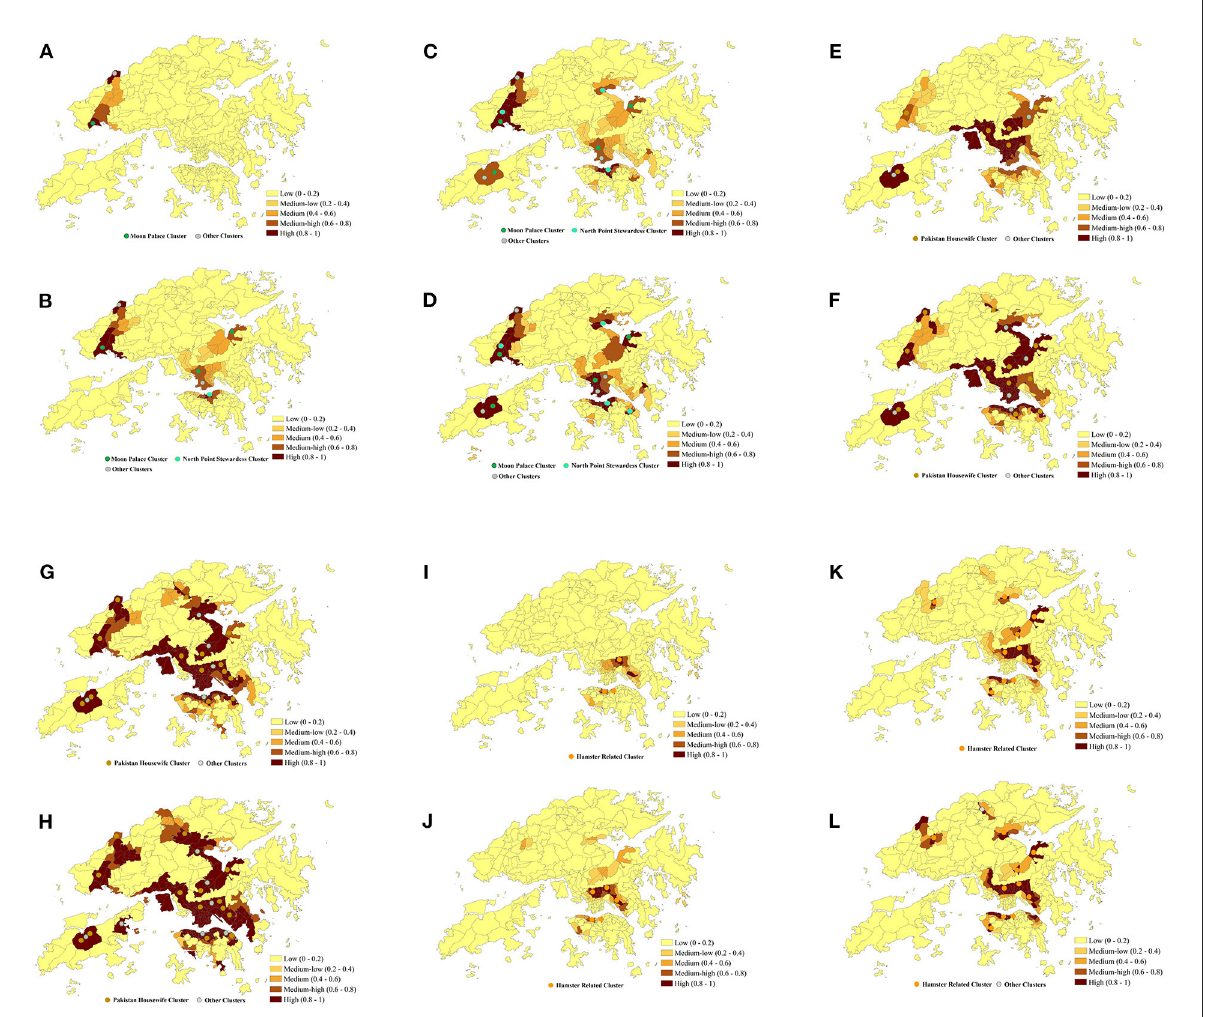
FIGURE5 Predicted risk of COVID-19 symptom onset across 291 TPUs in Hong Kong within 20 days after Omicron BA.1, BA.2, and Delta AY.127 (A–L) . The predicted COVID-19 symptoms onset risk was generated using the urban-community-level WKDE model. (A) 5th day after Omicron BA.1 entered the community. (B) 10th day after Omicron BA.1 entered the community. (C) 15th day after Omicron BA.1 entered the community. (D) 20th day after Omicron BA.1 entered the community. (E) 20th day after Omicron BA.2 entered the community. (F) 10th day after Omicron BA.2 entered the community. (G) 15th day after Omicron BA.2 entered the community. (H) 20th day after Omicron BA.2 entered the community. (I) 5th day after Delta AY.127 entered the community. (J) 10th day after Delta AY.127 entered the community. (K) 15th day after Delta AY.127 entered the community. (L) 20th day after Delta AY.127 entered the